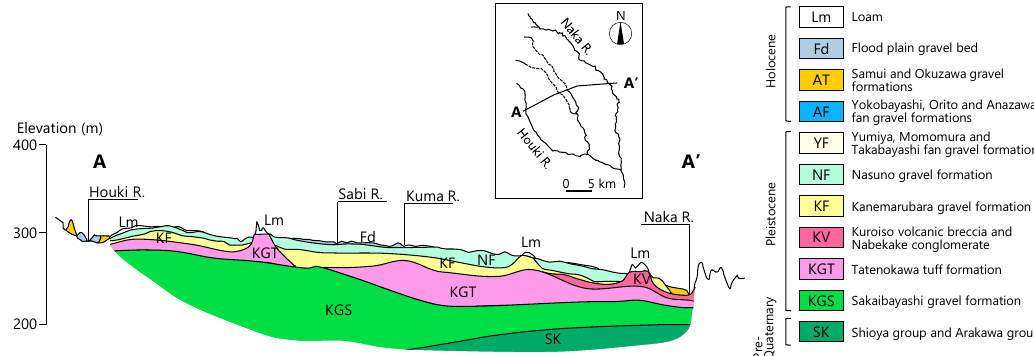
Figure 2. Geological cross section of the Nasunogahara alluvial fan (modified from the Kanto Regional Agricultural Administration Office [31]).